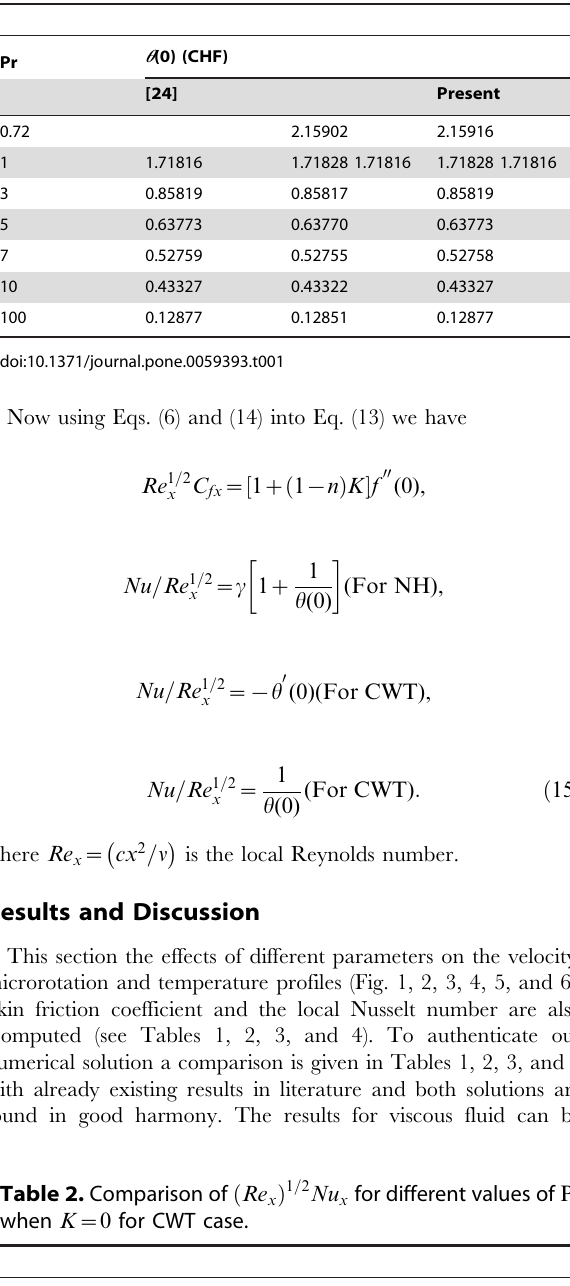
Table 1. Comparison of Re x ð